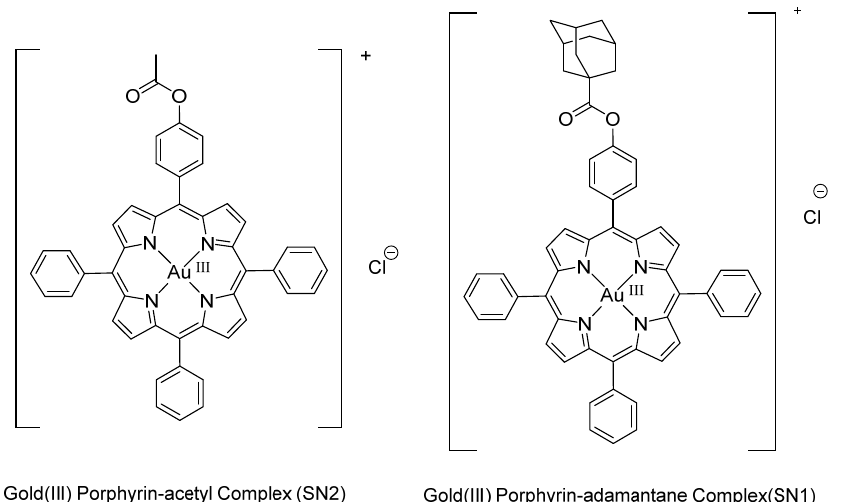
Figure 20. Chemical structure of gold(III) porphyrin-adamantane chloride complex (SN1) and gold(III) porphyrin-mono-acetate chloride complex (SN2) [114].